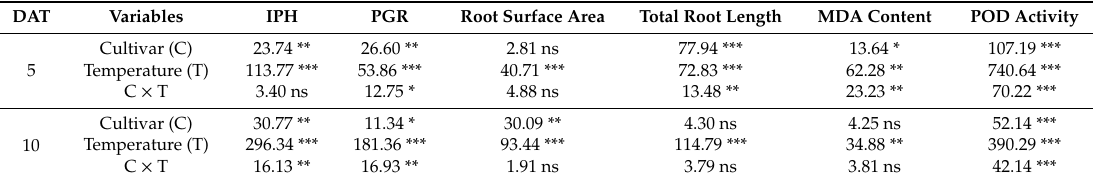
Table 1. F -value from two-way ANOVA analysis of e ff ects of cultivar and temperature treatment on IPH, PGR, root surface area, total root length, MDA content and POD activity.